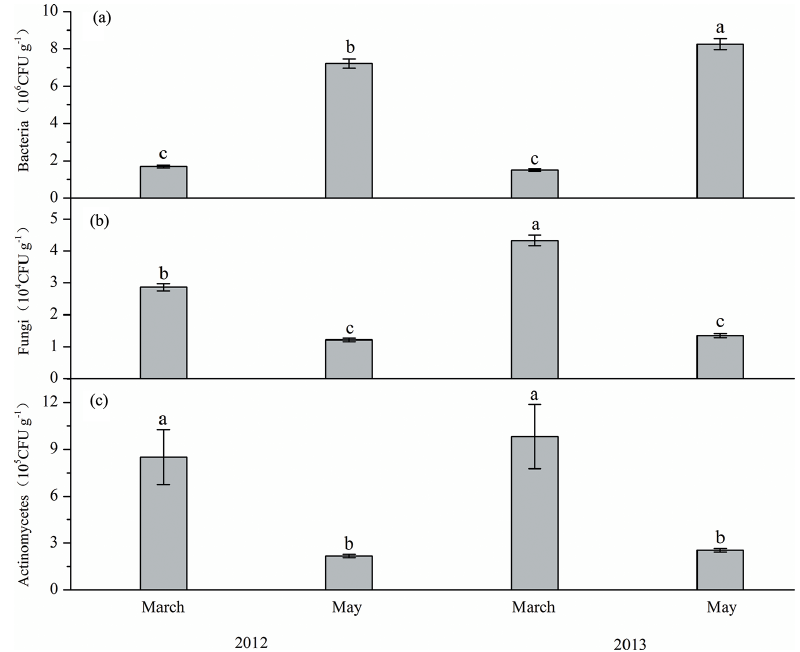
Figure 5. Changes in the number of bacteria (a) , fungi (b) , and actinomycetes (c) during the transition between freezing and thawing periods (mean ± SE; n = 15). The sampling time each year during the freezing period was on 15 March and during the thawing period was on 15 May. Different lowercase letters indicate significant differences of the interaction effects between season and year according to two-way ANOVA ( p < 0.05).